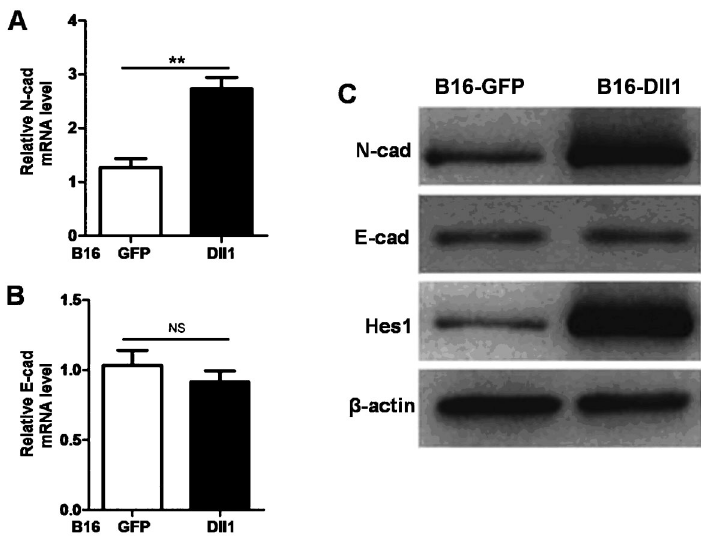
Figure 5. Dll1-mediated Notch activation induced N-cadherin (cad) expression. The ex- pressions of N-cadherin ( A ) and E-cadherin ( B ) were assessed by real-time RT-PCR, with b -actin as a reference control. C , The protein levels of Hes1, N-cadherin, E-cadherin in tumor cells were examined with Western blot. Data are reported as means±SD. **P , 0.01, unpaired Student t -test, n=6. NS: not